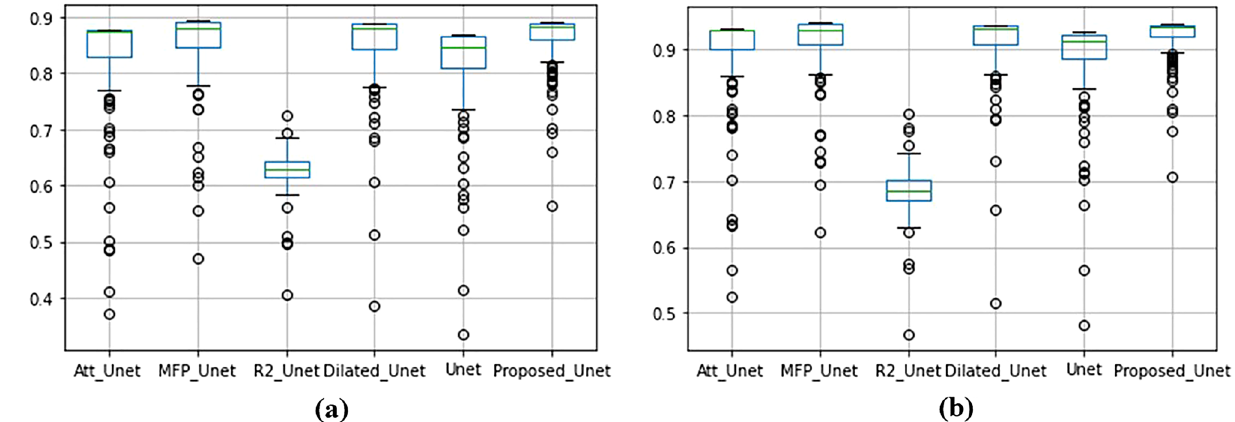
Figure 6. Comparing standard deviations and median results of Dice and Jaccard coefficients for foot data. Dice ( a ), Jaccard ( b